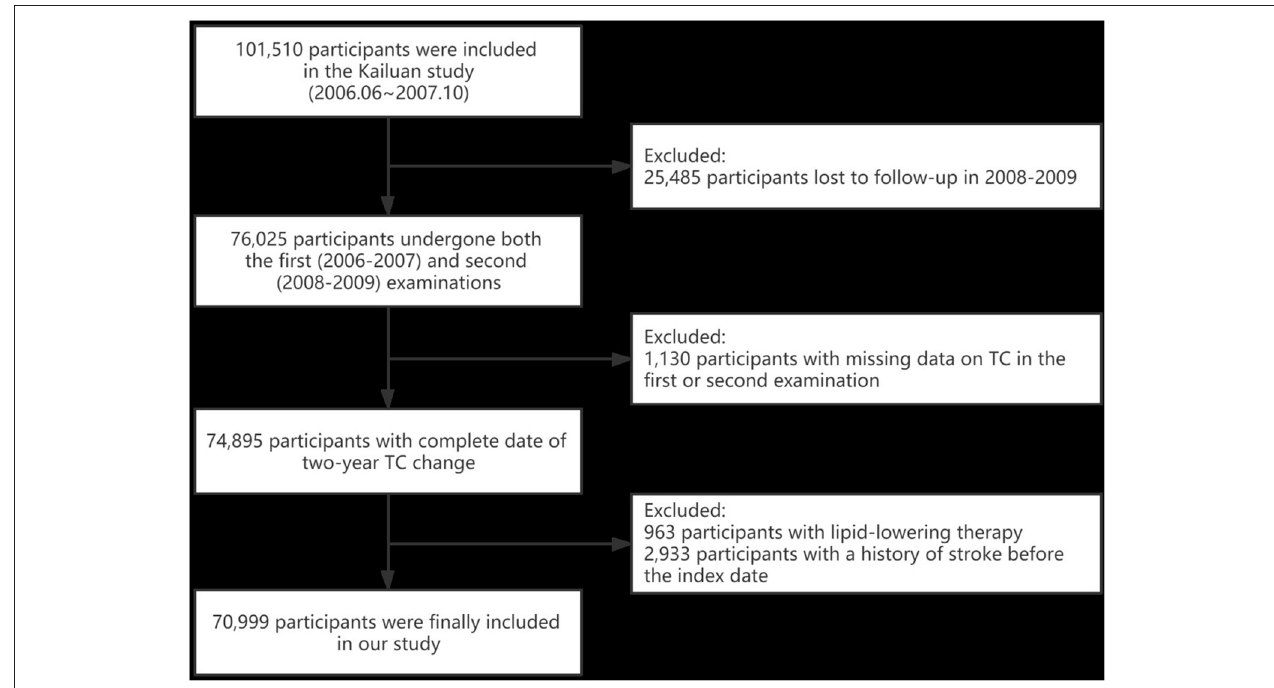
FIGURE 1 | Flow chart for selection of study participants. TC, total